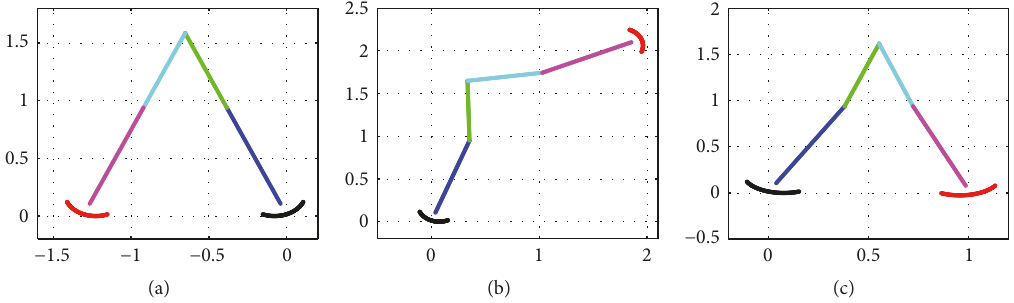
Figure 13: AR at representative time (a) 𝑡 = 0( s ) , (b) 𝑡 = 𝑇 = 1.01 ( s ) , and (c) 𝑡 = 1.12 ( s ) . Number 1; curved part of elastic part of leg 2; number 2: linear part of elastic part of leg 2; number 3: link 4; number 4: link 2; number 5: linear part of elastic part of leg 1; number 6: curved part of elastic part of leg 1.